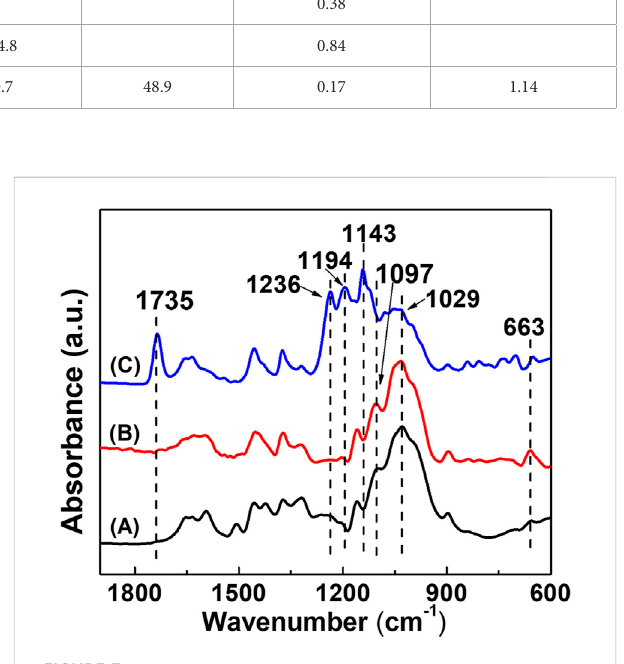
FIGURE 3 ATR-FTIR spectra of (A) BPC, (B) BPC-TiO 2, and (C) BPC-TiO 2